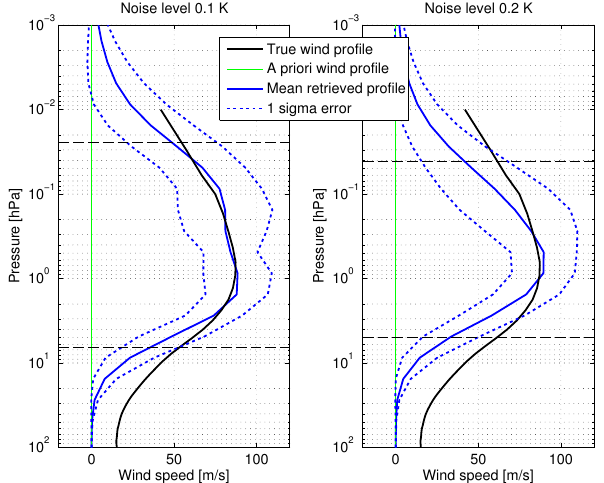
Figure 10. Monte Carlo error simulations for measurements taken with the old double sideband receiver for typical noise levels. The results in the left panel correspond to days with clear sky or dry clouds (noise level 0.1K) while the results shown in the right panel correspond to days with higher opacity as in the case of wet clouds (noise level 0.2K). The dashed lines delimit the trustable altitude region. The true profile is the wind profile that was used to generate the synthetic spectra that were fed to the retrieval